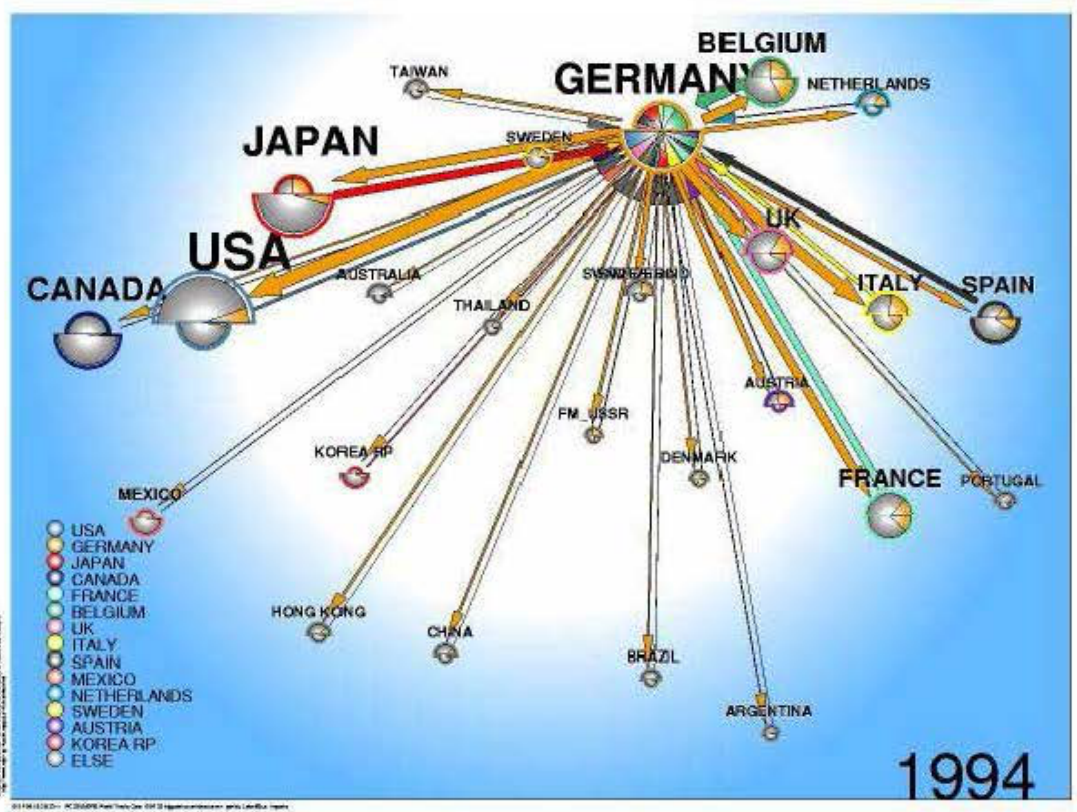
Figure 4: Japan's ,-crscl~ Germany's Penetration ofThinl